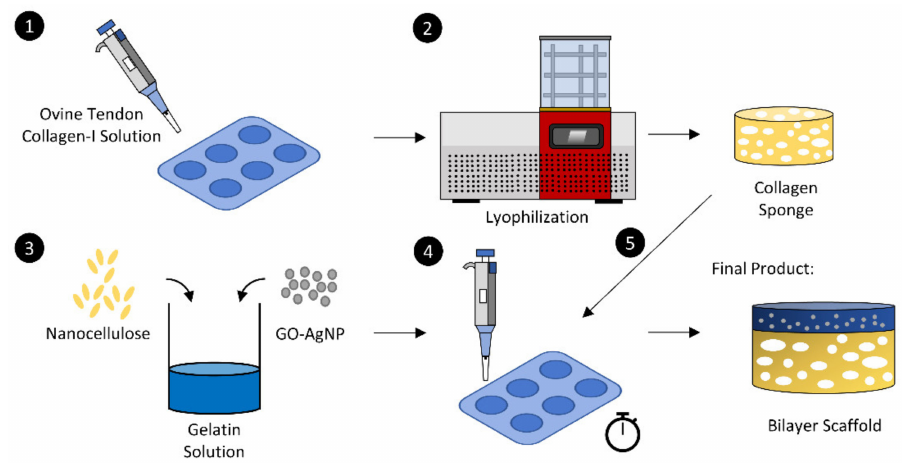
Figure 1. Schematic illustration of the fabrication process of the bilayer